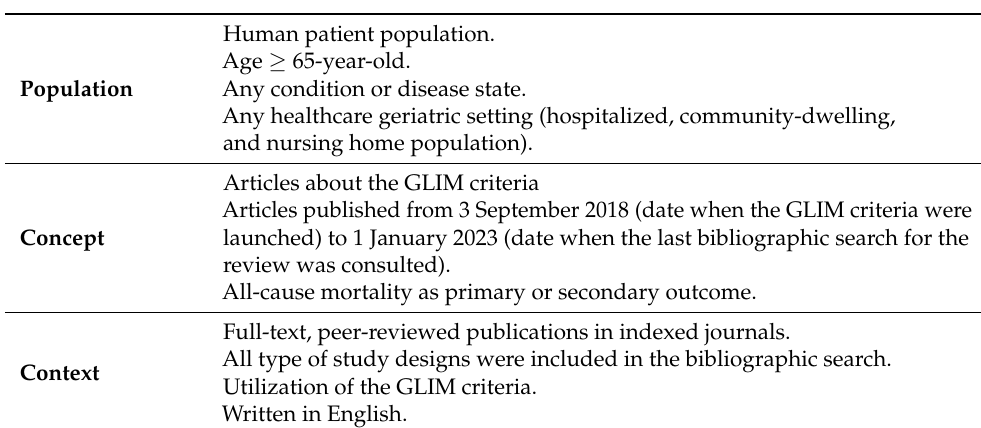
Table 1. Inclusion criteria of the scoping review